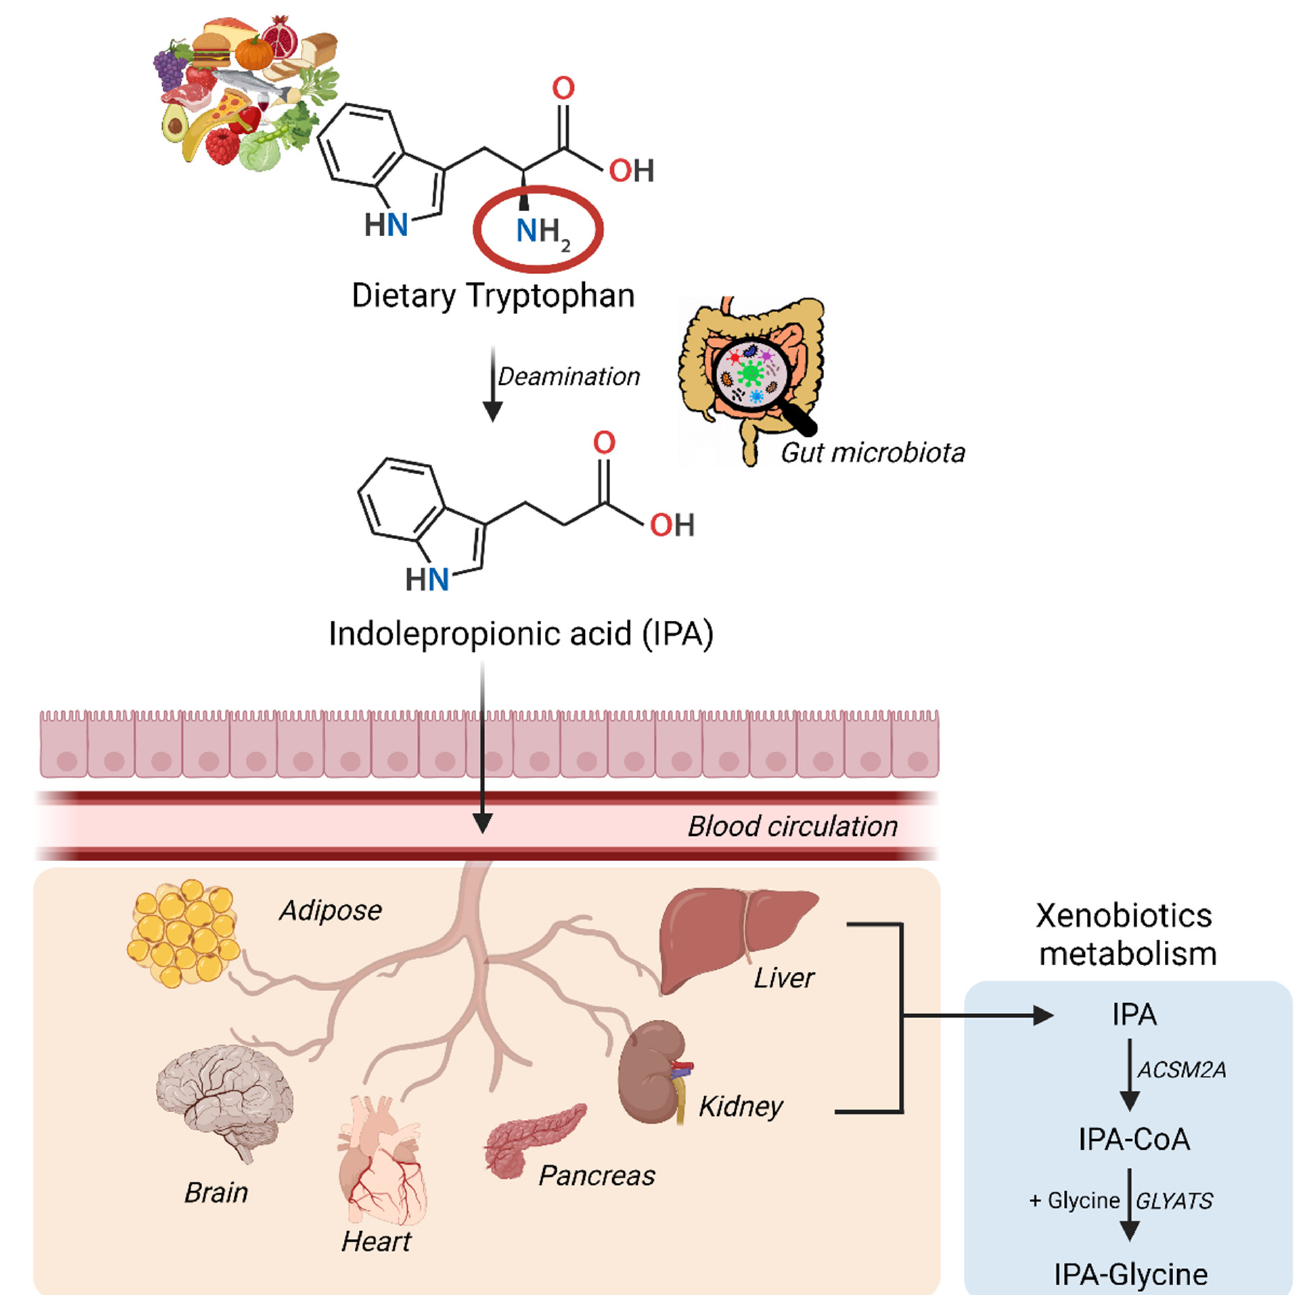
Figure 1. Synthesis and conversion of indolepropionic acid in humans. Dietary tryptophan is deaminated via the gut microbiota into IPA, that then enters the blood circulation directly from the gut epithelium. IPA via the circulation gains access to multiple organs, ultimately ending up in liver or kidney to be metabolized and excreted out of the body. ACSM2 —Acyl-CoA synthetase medium chain family member 2A; GLYATS —Glycine-N-acyltransferase.